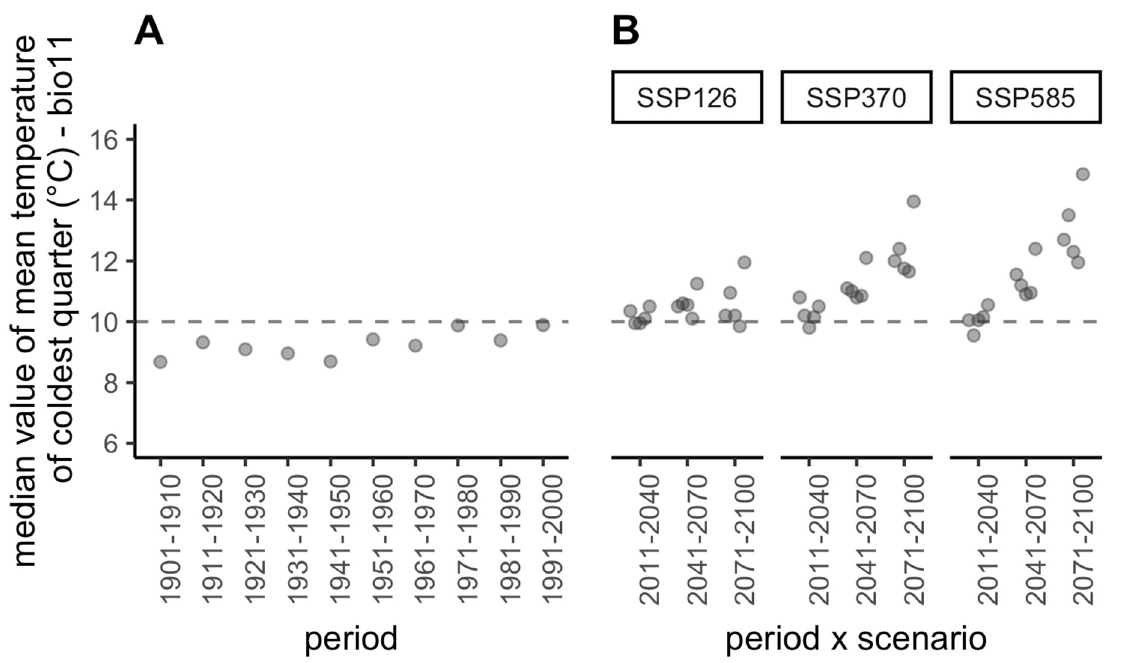
Figure 4. Past and future projections of temperature for the coldest quarter. ( A ) Median value of bio11 (mean temperature of coldest quarter) over all sampling sites projected in the past. ( B ) Median value of bio11 over all sampling sites projected in the future under three shared socio-economic pathways (SSPs, three facets) and five global circulation models (GCMs, five points per facet jittered along abscissa) that reflect uncertainties regarding the response of humans to climate change and the evolution of physical processes in the atmosphere, oceans, cryosphere, and land surface, respectively (see Table S1c for details). The dashed line shows the current median value (for the period 2000–2018).